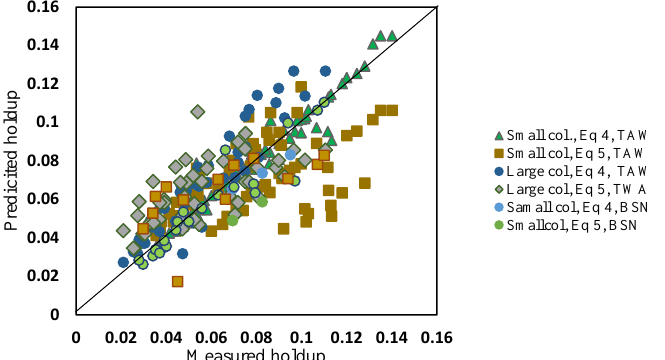
Figure 9. Comparison of the predicted holdup from the two correlations (4 and 5) with the measured values of (Korchinsky and Bastani 1993) [20]; and (Korchinsky and Al-Husseini 1986) [21].